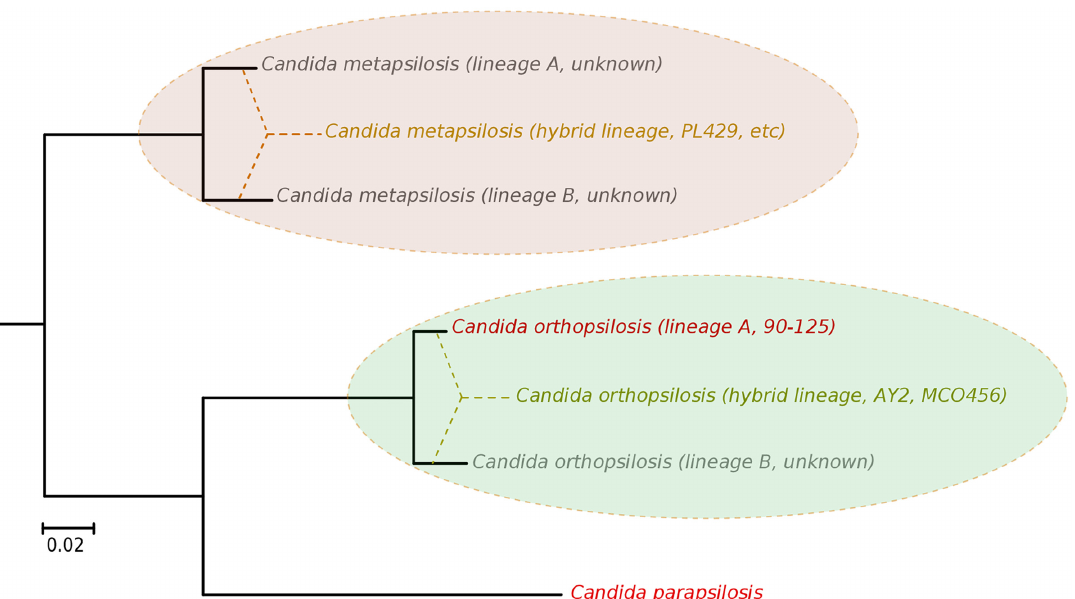
Fig 6. Phylogenetic relationships between C . parapsilosis complex lineages. Distance between the distinct lineages in C . orthopsilosis and C . metapsilosis have been inferred from heterozygous genomic regions in the hybrid strains. The origin of hybrid lineages have been schematically indicated by super-imposing dashed lines connecting different branches in the phylogeny. Strains representing the different lineages are indicated. Lineages whose existence is inferred from the hybrid strains but for which a representative strain is not available are indicated as unknown.